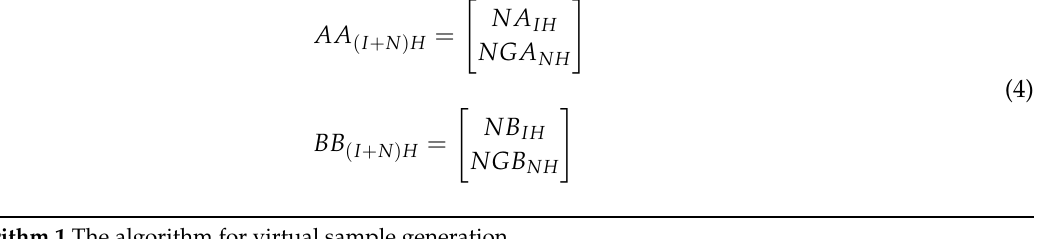
Algorithm 1 The algorithm for virtual sample